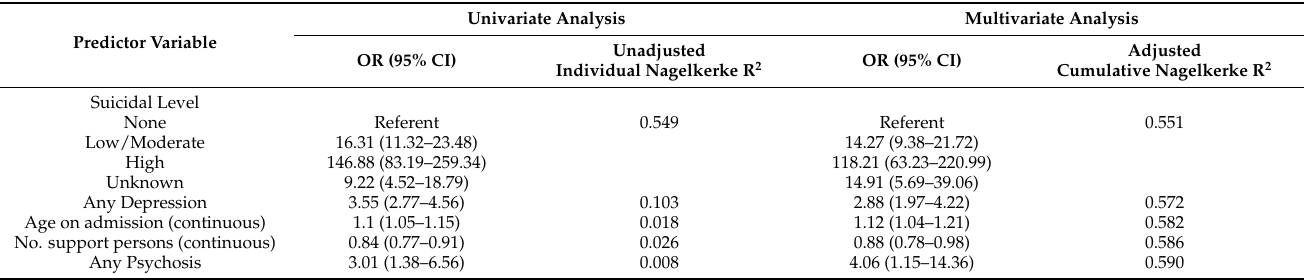
Table 4. About here: Univariate and multivariate analysis of variables predicting referral for psychi- atric